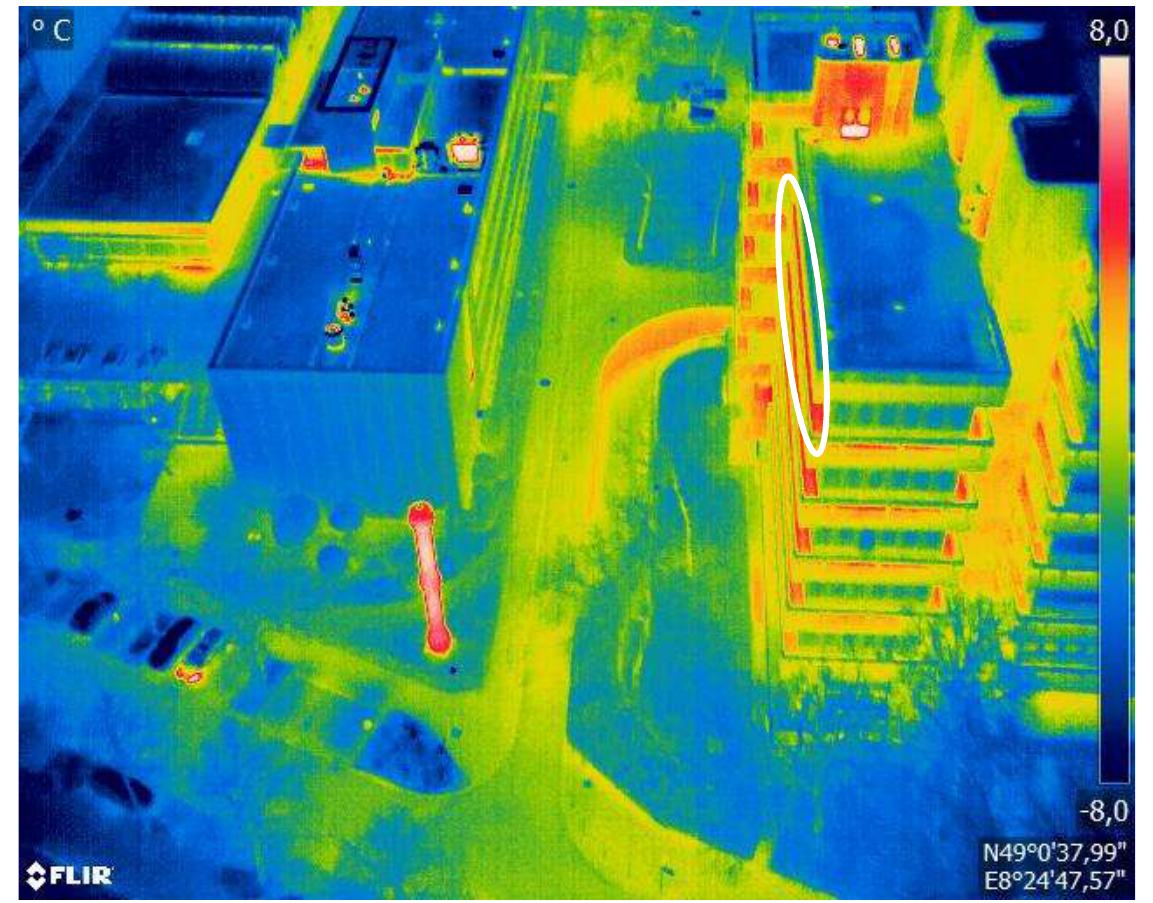
Figure A9. Example: thermal bridge of a balcony slab.